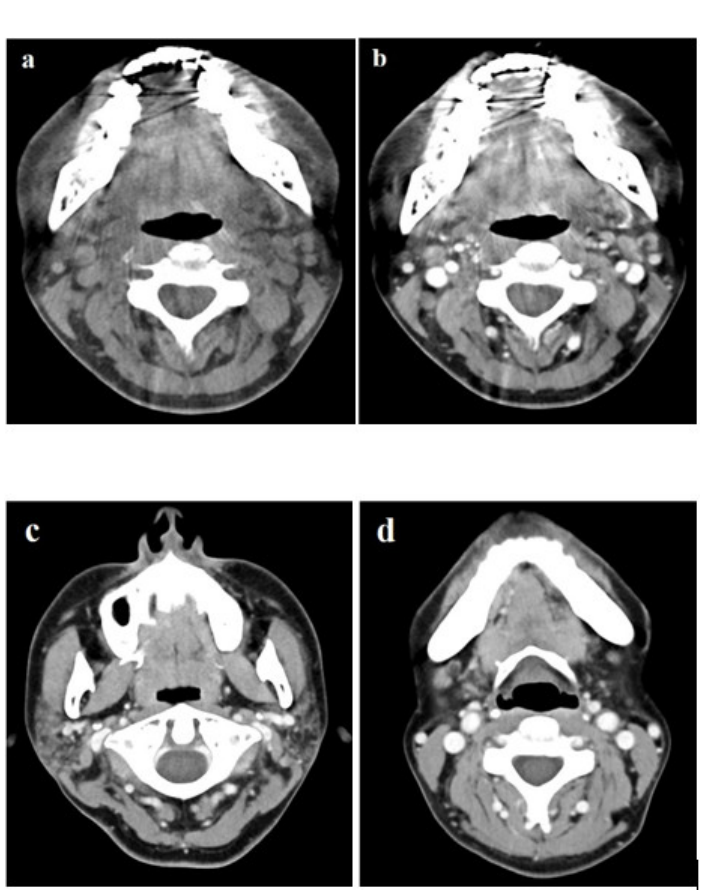
Figure 2. The lesions are not visible on non-enhanced axial ( a ) and enhanced axial CT ( b ) images owing to the presence of severe beam hardening artifacts by dental prosthesis. The contrast-enhanced CT ( c ) image shows multiple granulonodular opacities with partially fatty and mildly atrophic changes in both parotid glands. The contrast-enhanced CT ( d ) shows total fatty degeneration of both submandibular glands, however, glandular volume is conserved.